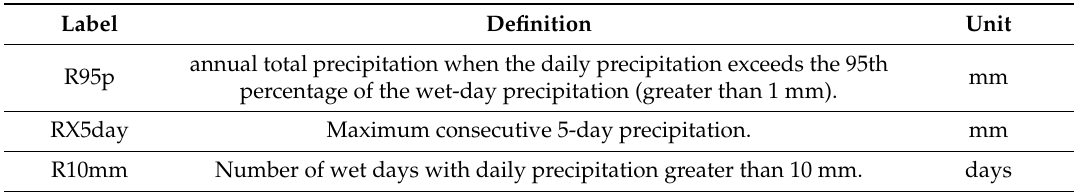
Table 2. Information of extreme rainfall indices used in this study.